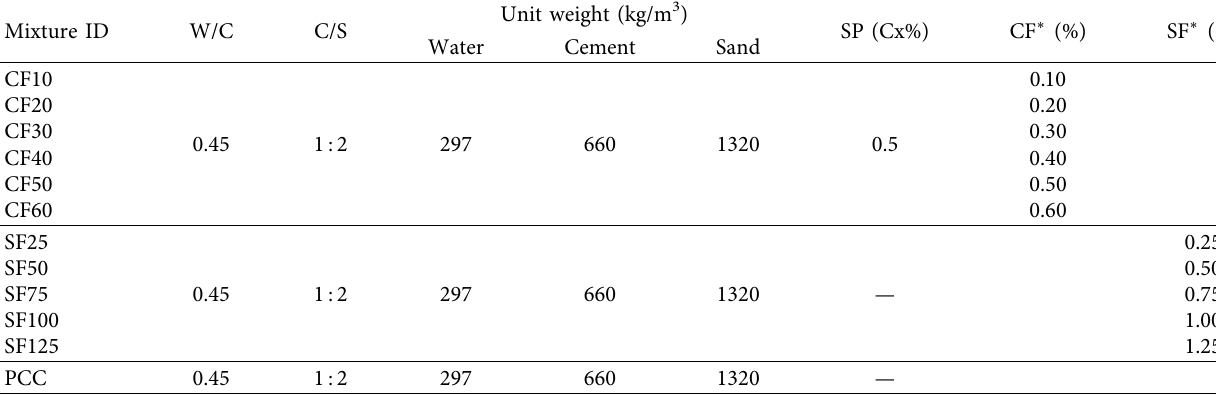
Table 3: Mix proportions design of cement